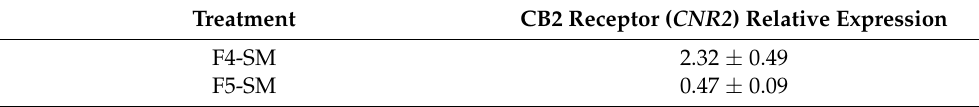
Figure 4. Cell viability of A172 cells following treatment with F4-SM ( a ) and F5-SM ( b ), with or without CB1 and CB2 inverse agonists (IA), a TRPA1 blocker (B), and TRPV1 or TRPV2 antagonists (AN) for 48 h. ( c ) The effect of IA, B, or NA on cell viability. Cells were treated with F4-SM (12 µ g/mL) or F5-SM (10 µ g/mL) in addition to the receptors IA, B, or AN (10 µ M). Cell viability was determined by XTT assay as a function of live cell number. Doxorubicin (Doxo, 0.5 µ g/mL) served as a positive control. Control is vehicle control (1.1% v / v methanol + 1% DMSO). Error bars indicate ± SE ( n = 3). Levels with different letters are significantly different from all combinations of pairs according to the Tukey–Kramer honest significant difference (HSD; p ≤ 0.05). Table 2. Quantitative PCR determination of the RNA steady-state level of CB2 receptor ( CNR2 ) gene in A172 cell line, after treatment with F4-SM or F5-SM (10 µ g/mL) for 12 h relative to control. Methanol (control) treatment served as a solvent (vehicle) control. Gene transcript values were determined by quantitative PCR. Mean values ± SE are shown ( n =